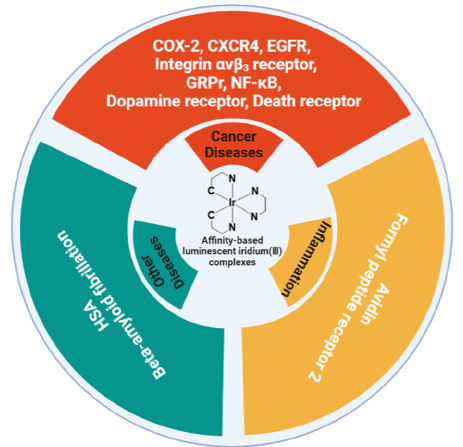
Figure 2. Affinity-based luminescent iridium( Ⅲ ) complexes for the detection of different disease- associated proteins.